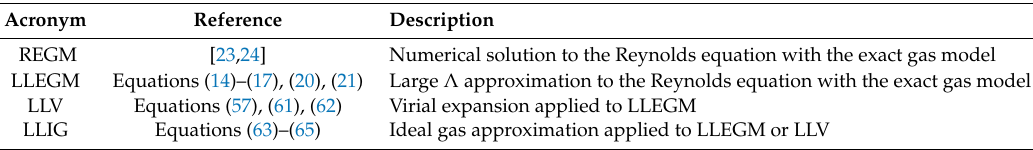
Table 1. Acronyms and